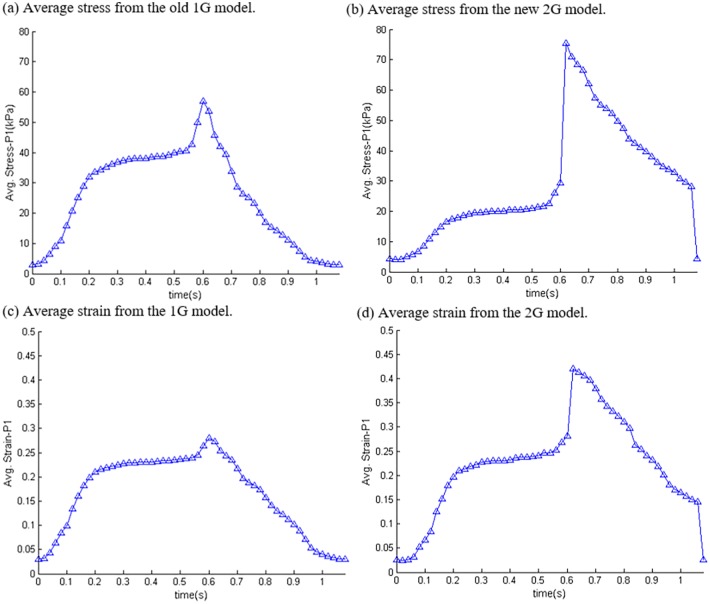
Stress and strain variations (average value on the inner RV surface) in one cardiac cycle from a TOF patient showing the difference between the two models.Sudden increase at the end of diastole and sudden decrease at the end of systole reflected our omission of the two isovolumic phases. (a) Average stress from the old 1G model; (b) average stress from the new 2G model; (c) Average strain from the 1G model; (d) average strain from the 2G model.